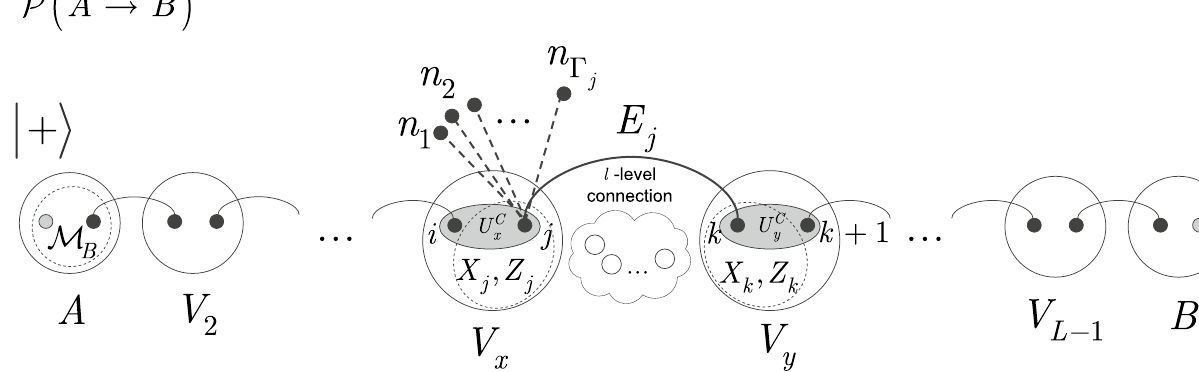
Figure 2. Evaluation of target function value F of a computational problem via a distributed computational B ) between a distant source node A and receiver node B in a distributed system N with L path P ( A → 2, . . . , L 1 , with multipartite entanglement in the local nodes. Alice applies an intermediate nodes V x , x = −